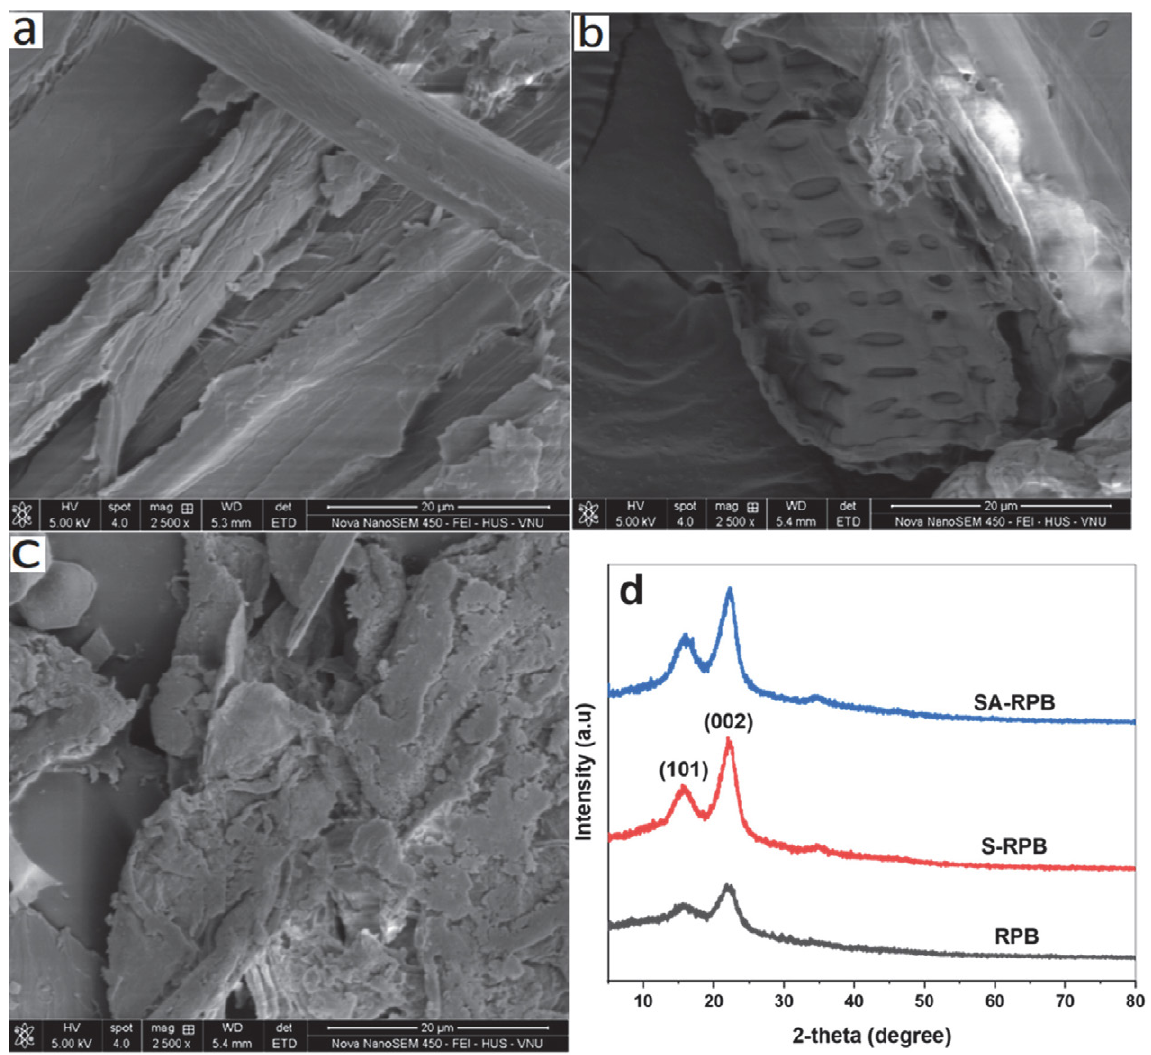
Fig. 1. Morphology and crystallization of samples; SEM images of (a) RPB, (b) S-RPB, and (c) SA-RPB; (d) XRD patterns of RPB, S-RPB, and SA- RPB